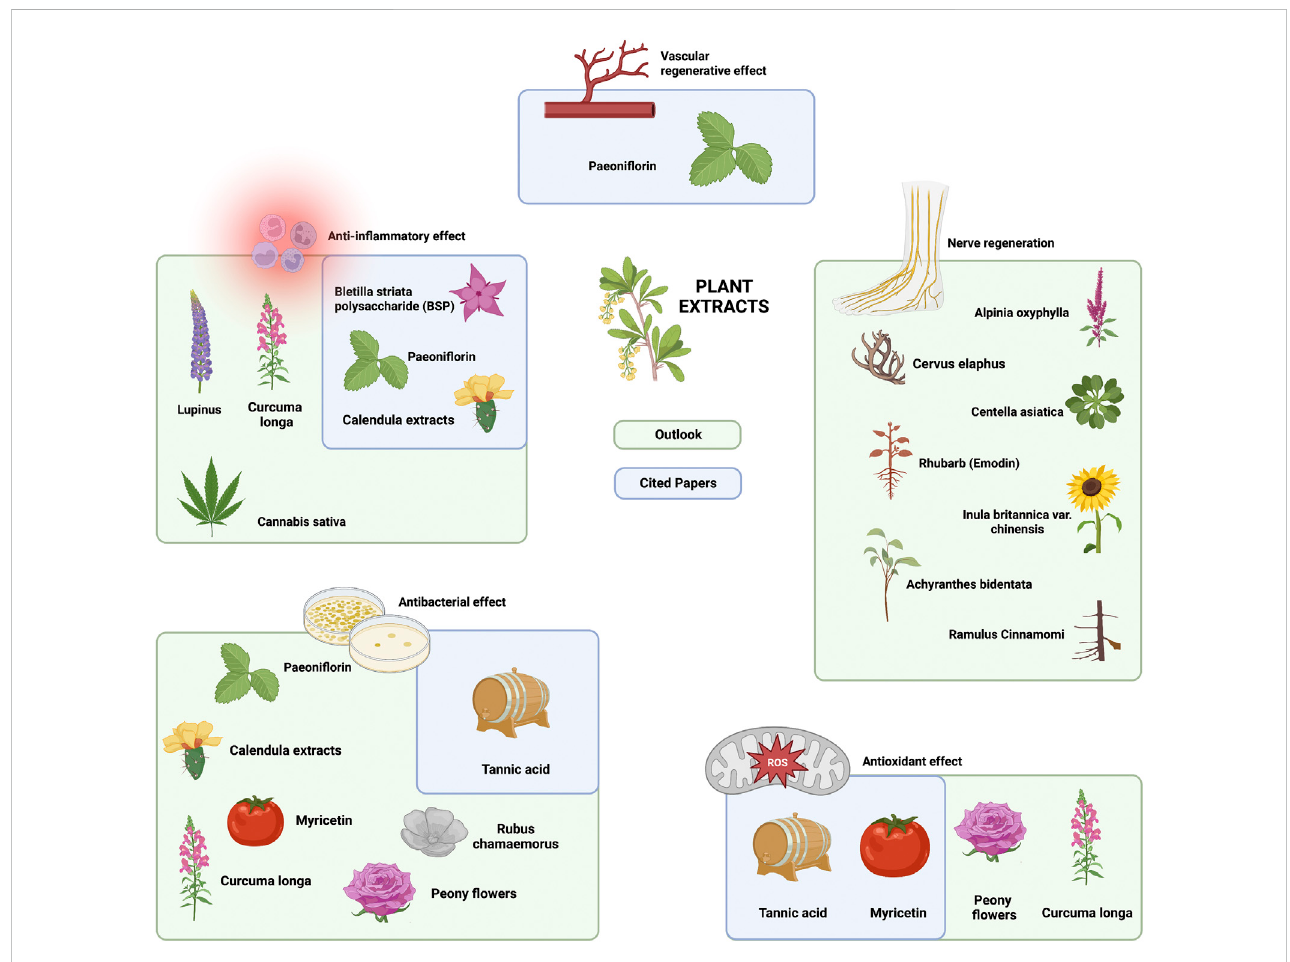
FIGURE 5 Current and future outlook of plant extracts in hydrogel composites in the treatment of chronic diabetic